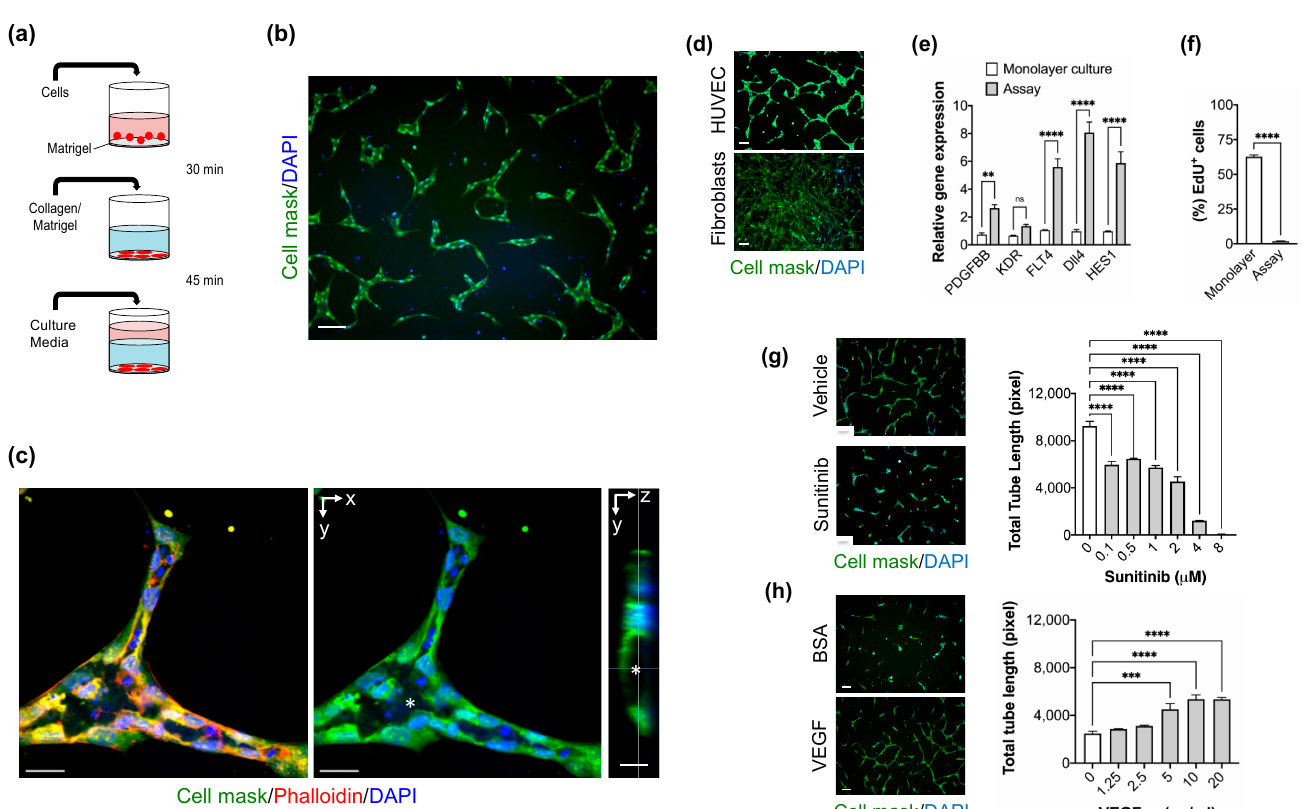
Figure 1. Optimization and validation of the novel 2D angiogenesis assay. ( a ) Workflow of the assay: HUVECs were seeded on coated 96-well plates with a thin layer of Matrigel. Extracellular matrix gel (type I collagen/Matrigel) was added on adhered HUVEC. Following gel polymerization, media was added and incubated for 48 h. ( b ) Representative fluorescent image showing the vascular-like structures formed by HUVEC cultured with type I collagen/Matrigel mixture. Cells were stained with HCS Cell Mask (green), and DAPI (Blue). Scale bar = 100 μ m. ( c ) Confocal Z-stack imaging of a vascular-like unit showing the lumen (*) formation is associated with polarized endothelial cells. Cells are stained with HCS Cell Mask (green), Phalloidin (Red), and DAPI (Blue). xy plane (middle) and yz plane (right). Scale bar = 30 μ m. ( d ) Morphology of cultured fibroblasts compared to HUVEC using the angiogenesis assay. Scale bar = 100 μ m ( e ) Levels of pro-angiogenic genes: PDGFB , KDR , FLT4 , Dll4 , and HES1 mRNA expression detected by quantitative RT-PCR in HUVEC cultured in the angiogenesis assay compared to HUVEC cultured in monolayer settings. Error bars, mean ± SEM, n = 3. Unpaired t-test, ** p < 0.01, *** p < 0.001 compared with monolayer culture conditions. (ns) non significant. ( f ) The proliferative activity of HUVEC cultured in angiogenesis assay for 48 h as measured by EdU staining, n = 6 per condition, unpaired t -test, Data are mean ± S.E.M, ** p < 0.01, *** p < 0.001. ( g ) Right panel , the effect of the anti-angiogenic compound, Sunitinib, with various concentrations on the tube formation (total tube length) using the angiogenesis assay. Data are shown as mean ± S.E.M. n = 3 wells per concentration. one-way ANOVA followed by Bonferroni’s post hoc test, **** p < 0.0001 compared to the vehicle. Left panel , representative fluorescent image of the cultures treated with Sunitinib (4 µ M) and DMSO (vehicle). Cells were stained with Cell Mask (green) and DAPI (blue). Scale bar = 100 µ m. ( h ) Effect of VEGF on tube formation. The assay was conducted in growth factor-free media (EBM). n = 3 wells per concentration. Error bars, mean ± S.E.M, one-way ANOVA followed by Bonferroni’s post hoc test, **** p < 0.0001 compared to vehicle. Left panel , representative fluorescent image of the cultures treated with VEGF (20 ng/mL) and Bovine Serum Albumin “BSA” (control). Cells were stained with Cell Mask (green) and DAPI (blue). Scale bar = 100 µ